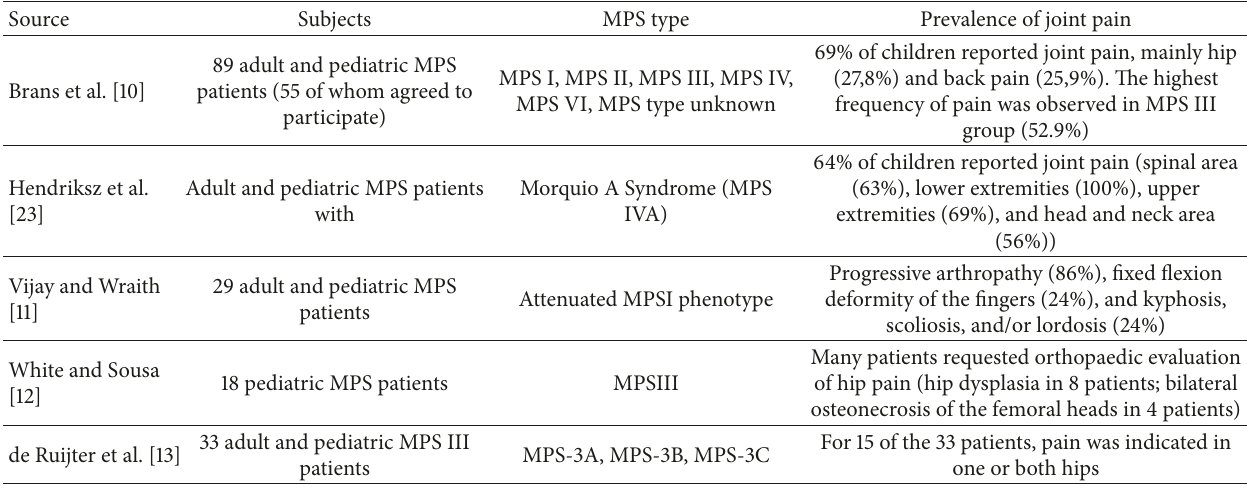
Table 1: Experiences about pain in children with